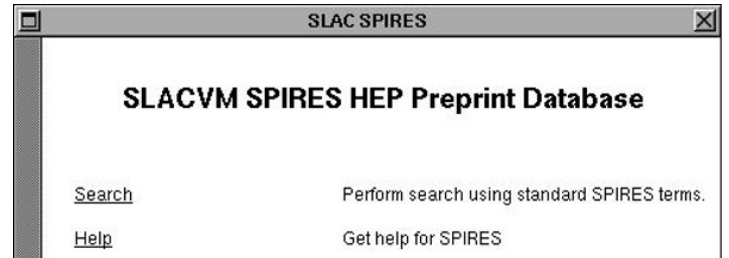
Figure 1. SPIRES-HEP